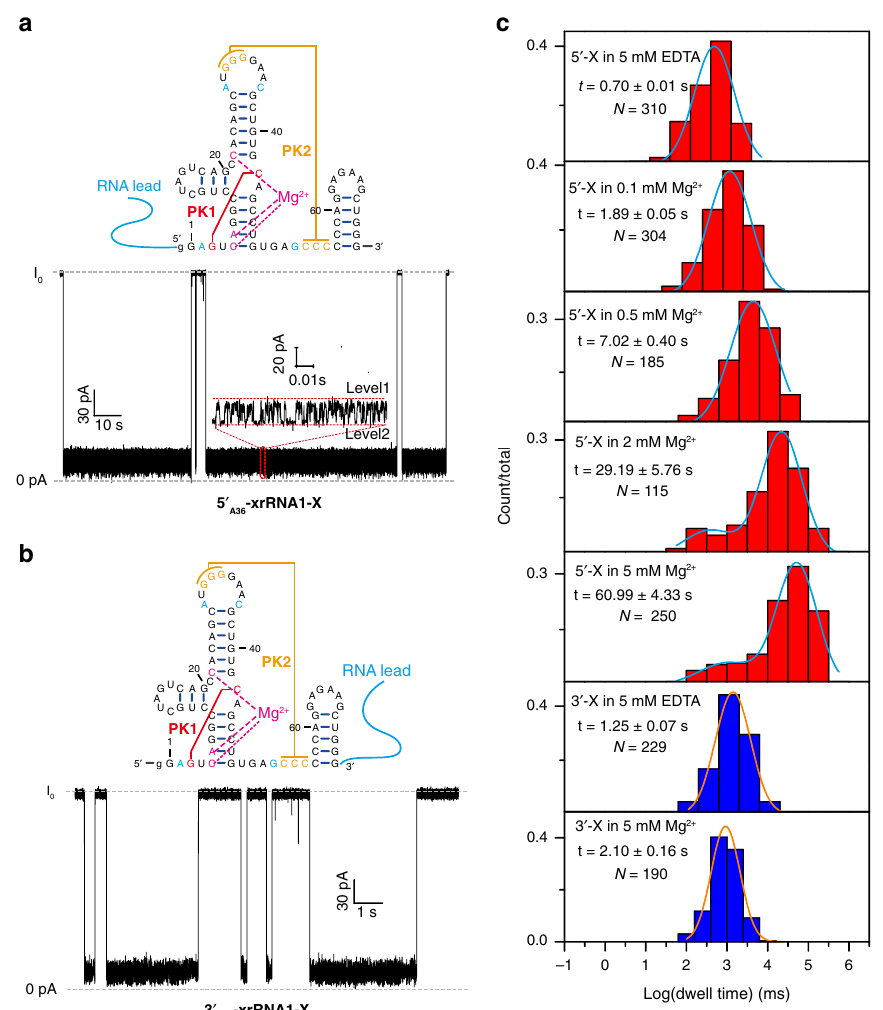
Fig. 3 Mechanical anisotropy of ZIKV xrRNA1-X highly depends on Mg 2 + . a , b Secondary structures and representative current traces for the unfolding and translocation of 5 ′ A36 -xrRNA1-X ( a ) and 3 ′ A36 -xrRNA1-X ( b ) through the nanopore in the presence of 5 mM Mg 2 + . c Dwell time distribution histograms for 5 ′ A36 -xrRNA1-X (red) and 3 ′ A36 -xrRNA1-X (blue) in different Mg 2 +